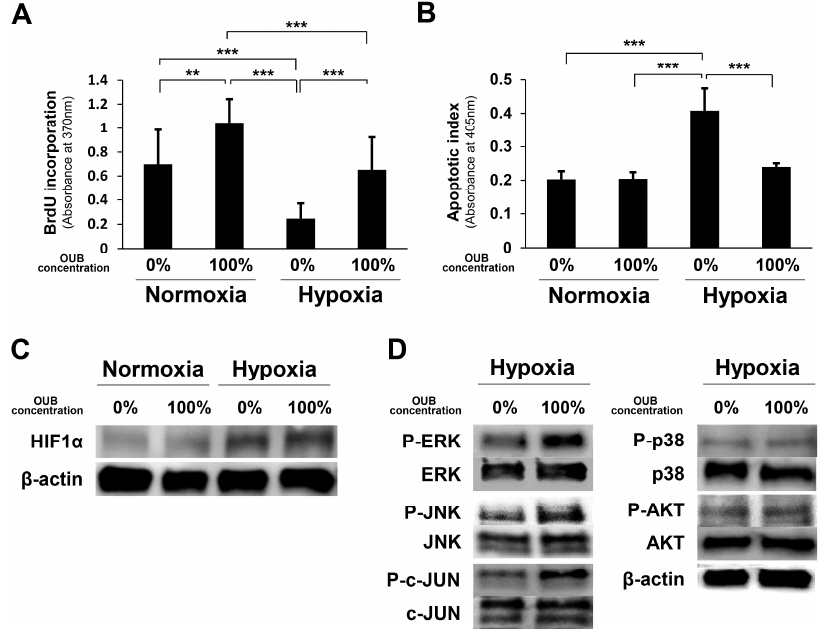
Figure 6. OUBs accelerate proliferation and inhibit apoptosis of SCs under hypoxic conditions in vitro.